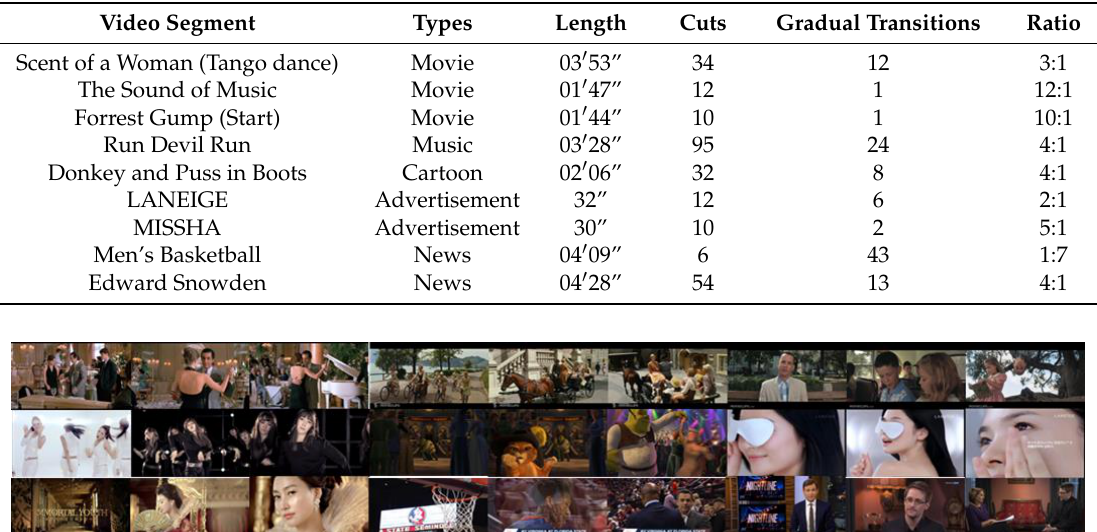
Table 5. The training videos for threshold selections.